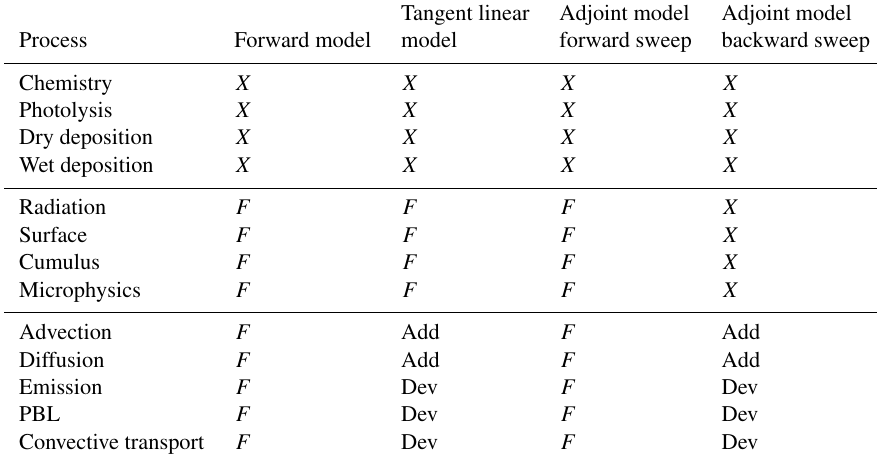
Table 2. Summary of variable dependence analysis for developing WRF-CO2 4D-Var component models on top of WRFPLUS. In the table, an “ F ” means a full physics scheme is used in the forward model, tangent linear model, or the forward sweep of the adjoint model. An “ X ” means a process is not needed for CO 2 treatment. A “Dev” means a process does not exist in WRFPLUS and has been developed for WRF-CO2 4D-Var. An “Add” means a process for CO 2 is simply added using the existing WRFPLUS code for other